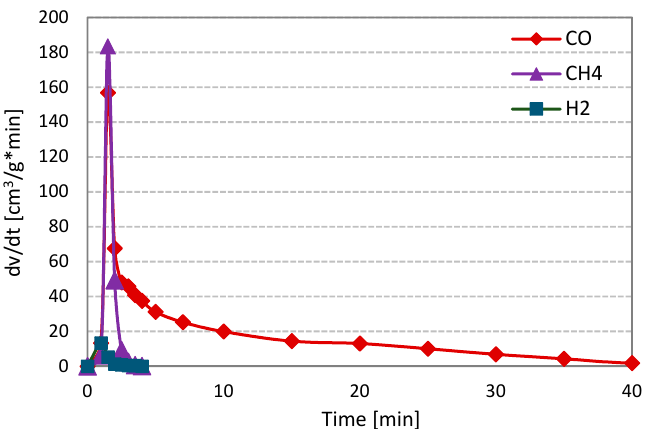
Figure 6. Changes in the formation rates of gas components during CO 2 gasification of RDF at 800 °C and 1 MPa.